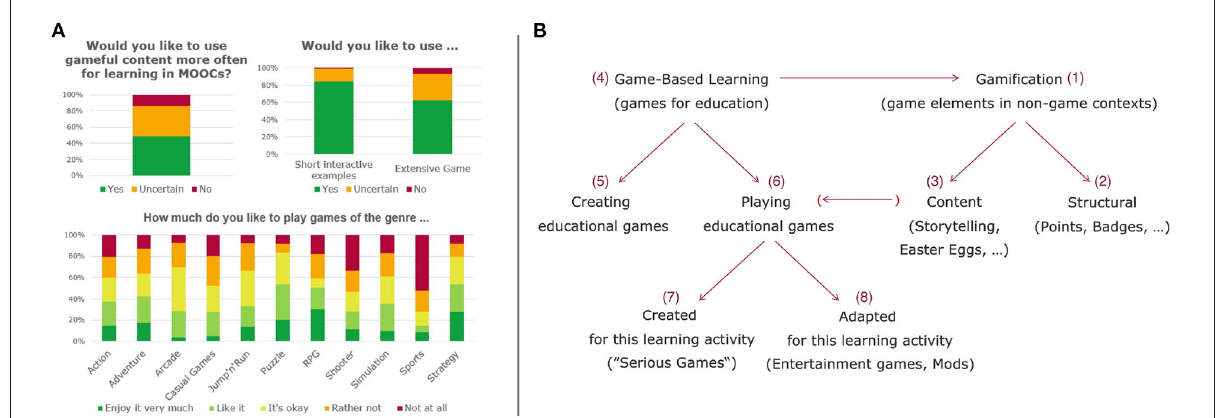
FIGURE1 (A) Results from the survey conducted at the start of the experiment, showing learner preferences regarding gameful elements (Hagedorn et al., 2018). (B) Possibilities of how to apply gameful learning through different means of gamification and game-based learning (Hagedorn et al.,